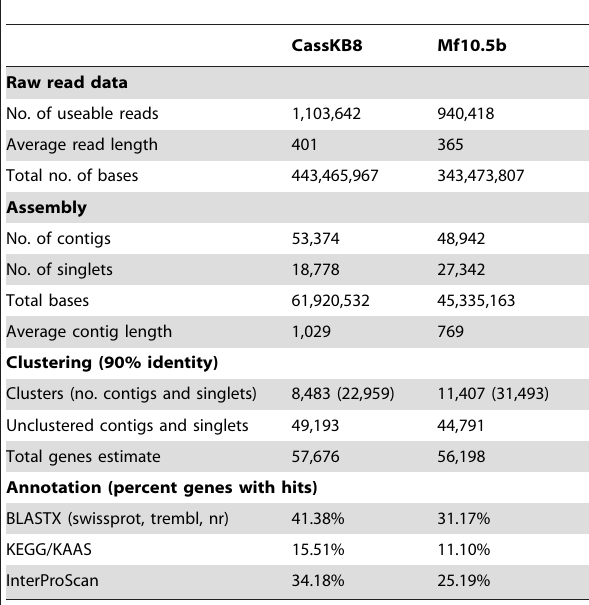
Table 1. Overview of the sequencing data, assembly, clustering, and annotation statistics.